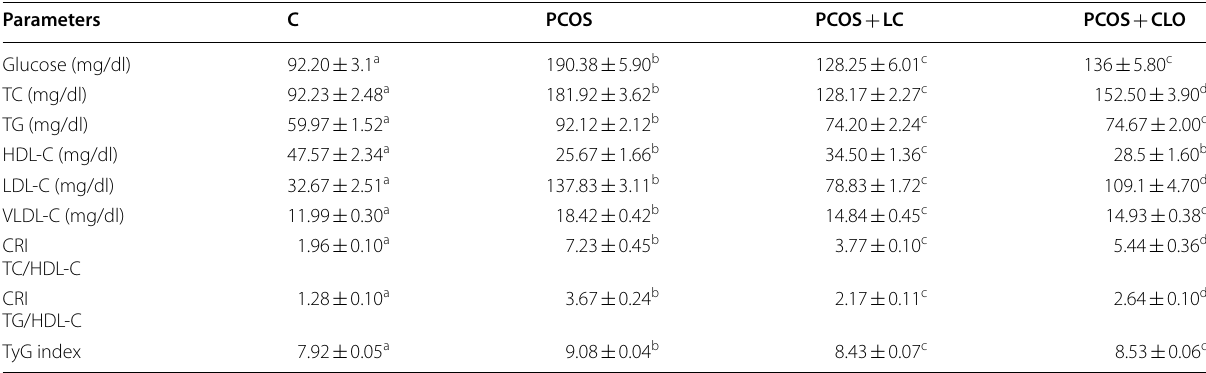
Table 2 Effect of l -Carnitine and Clomiphene citrate on serum metabolites of different groups in letrozole-induced PCOS rat model